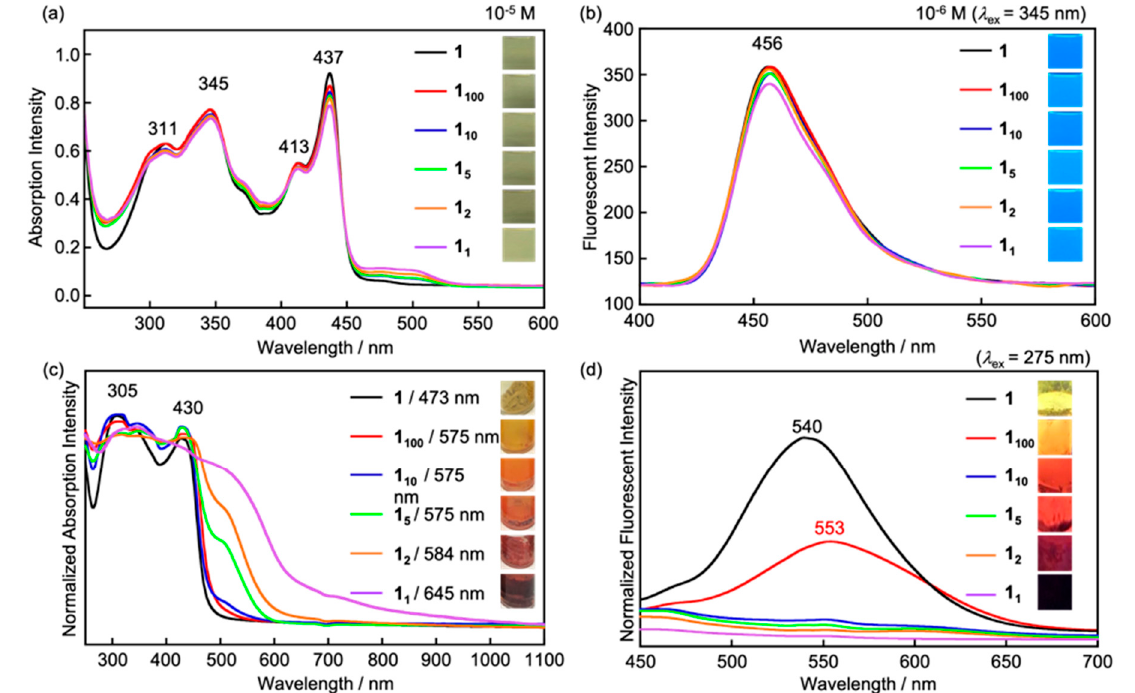
Figure 8. UV-vis absorption spectra and photographs in CHCl 3 solutions ( a ) and in liquid-crystalline (LC) states ( c ) and fluorescent spectra and photographs in CHCl 3 solutions ( b ) and in LC states ( d ) for complexes 1 12 with BSA.